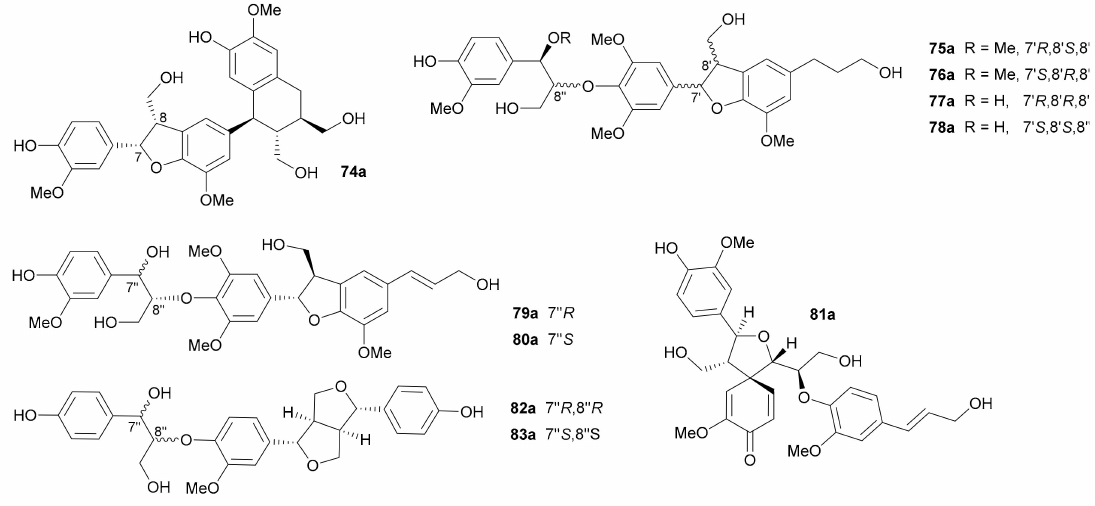
Figure 5. Structures of